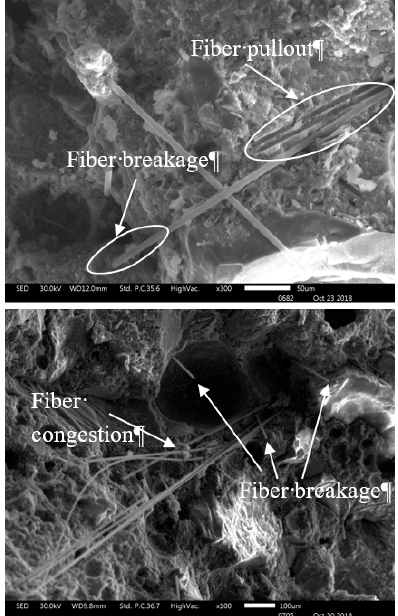
Figure 3. SEM of fracture surface of C3 .